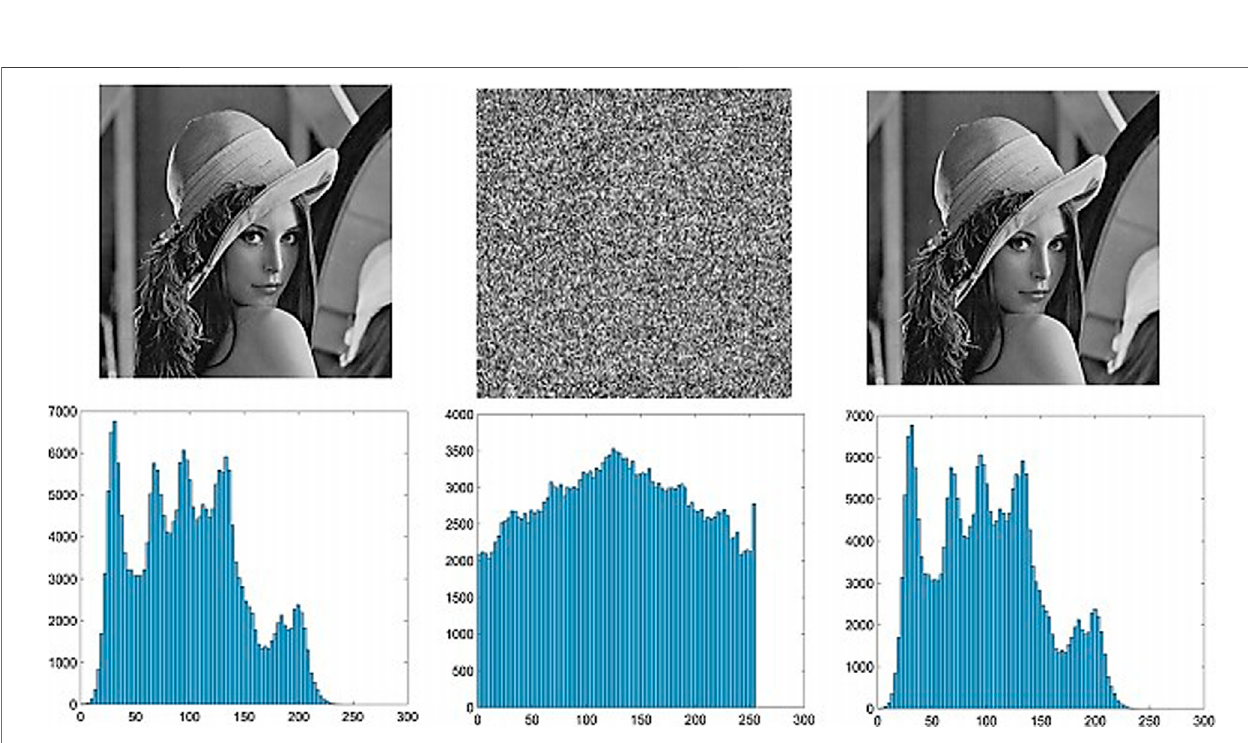
FIGURE 4 | Applying the proposed double encryption and decryption on Lena image.